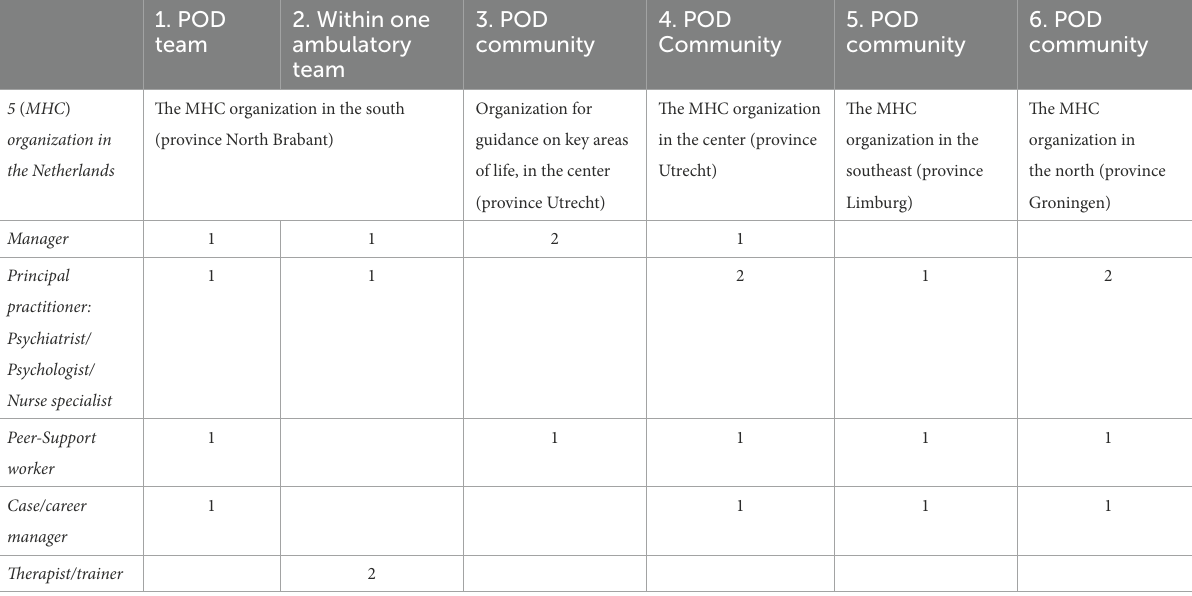
TABLE 1 Overview of POD networks and participants’ professional background per POD